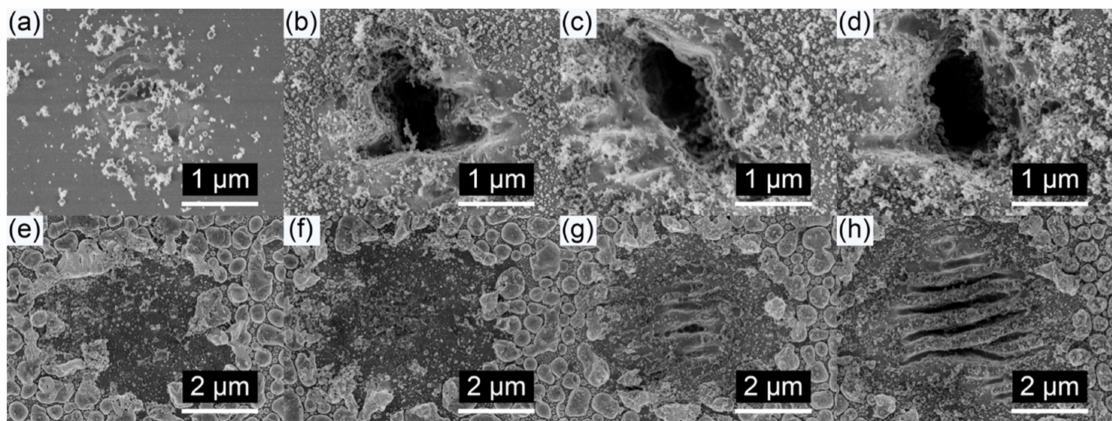
Figure 2. Scanning electron microscopy (SEM) images of the surface morphologies on bare silicon and BiIn-Si with different laser fluences of ( a , e ) 1.02, ( b , f ) 1.53, ( c , g ) 2.04, and ( d , h ) 2.55 J/cm 2 at a fixed laser pulse number of N = 200. ( a – d ) represent situations on bare silicon. ( e – h ) represent situations on